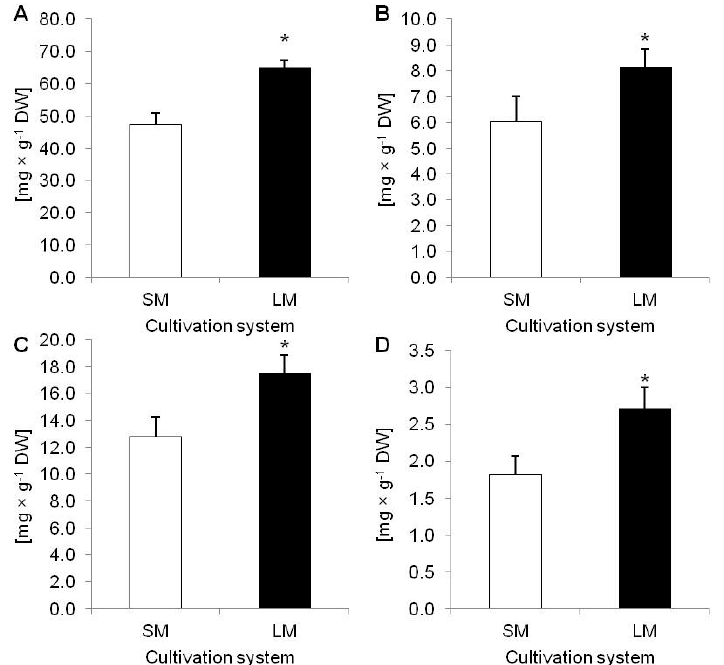
Figure 2. Accumulation of phenolic compounds in Dionaea muscipula plants cultivated on solid medium (SM) and in liquid medium with rotary shaking (LM); ( A ) total phenolic content; ( B ) phenylpropanoids; ( C ) flavonoids; and ( D ) anthocyanins depending on cultivation system; * significant difference between means at p < 0.05; bar—standard deviation.